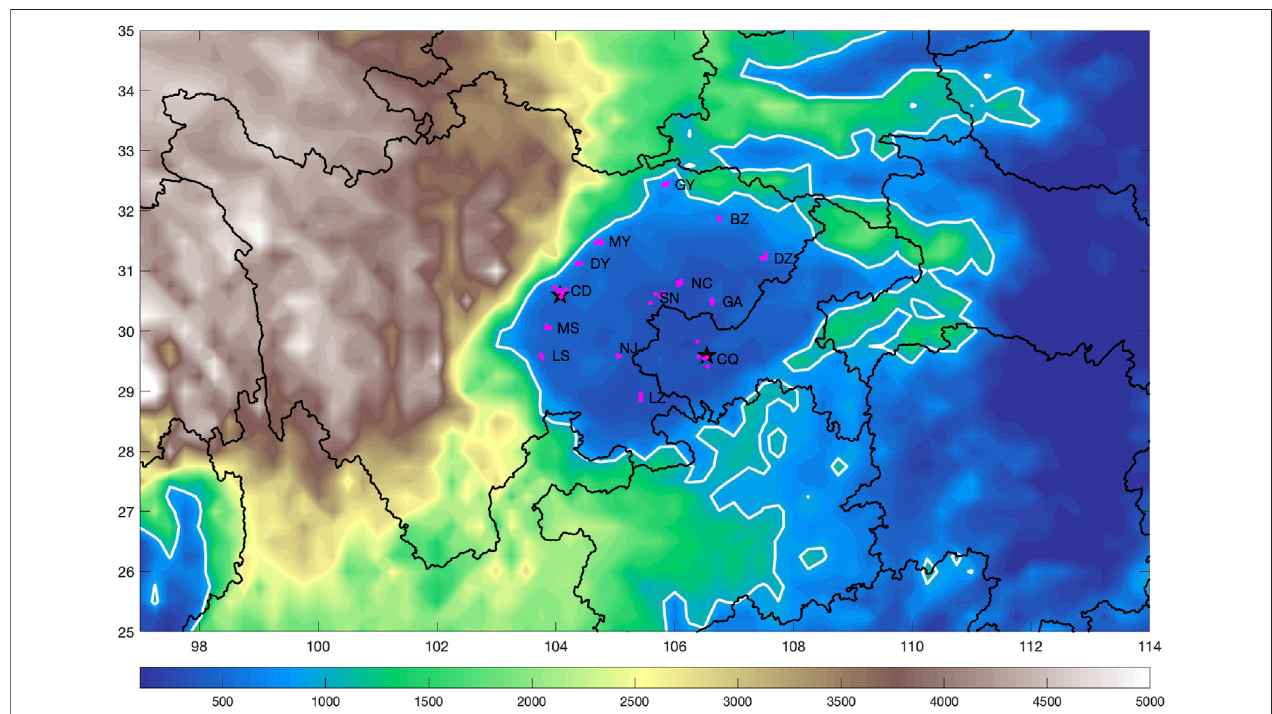
FIGURE1 | Spatial distribution ofelevation around the SichuanBasin(unit: m) and 64air quality observation stations in the basin. The edge ofthe Sichuan Basin is marked by the 1000-m contour line (white line). Magenta dots indicate the locations of the 64 air quality stations. GY (Guangyuan), BZ (Bazhong), MY (Mianyang), DY (Deyang), CD (Chengdu), MS (Meishan), LS (Leshan), NC (Nanchong), SN (Suining), NJ (Nenjiang), DZ (Dazhou), GA (Guang ’ an), CQ (Chongqing), and LZ (Luzhou) indicate the 14 cities in the basin. CD and CQ are marked by black